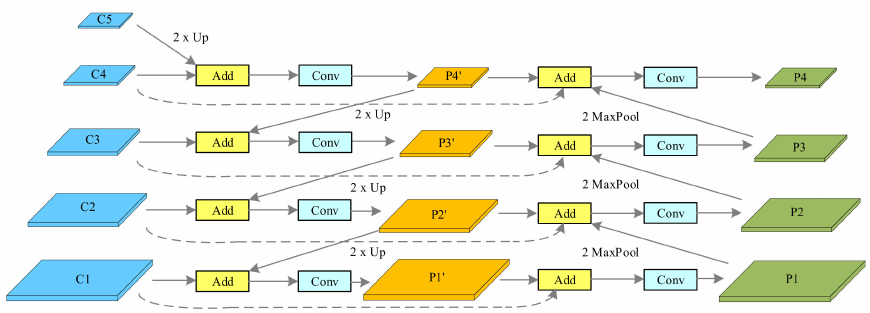
Figure 4. Structure of